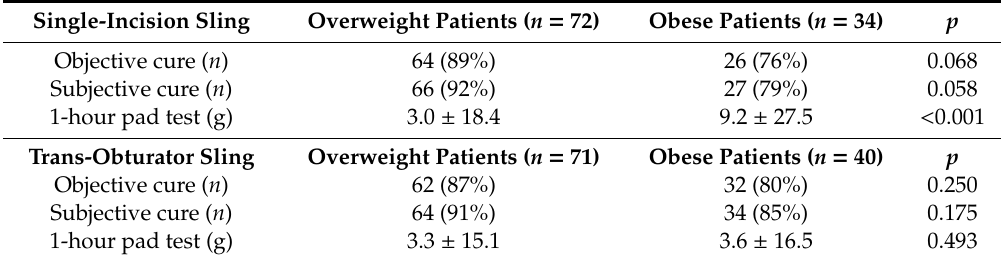
Table 5. Objective and subjective results after receiving a single-incision sling or trans-obturator